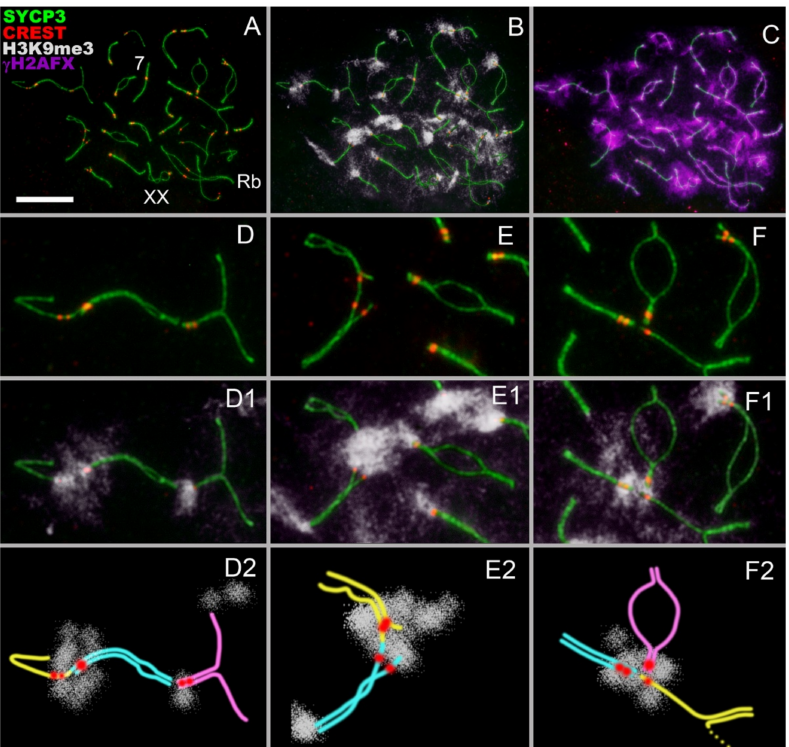
Figure 3. Meiotic contacts of nonhomologous chromosomes in zygotene and H3K9me3 histone distri- butions in E. alaicus spermatocytes. Immunostained nucleus ( A – C ), its enlarged parts ( D – F , D1 – F1 ), and schemes of meiotic contacts ( D2 – F2 ) are presented. Axial and lateral elements of the SCs were visualized using the anti-SYCP3 antibody (green). Kinetochores were detected using the anti-CREST antibody (red). Heterochromatin was detected by means of an anti-H3K9me3 antibody (white). Chromatin inactivation was revealed using an anti- γ H2AFX antibody (violet). The non-Robertsonian chromosome is designated as 7 according to the karyotype [28,29]. The contact regions of nonhomol- ogous bivalents are localized in the H3K9me3 clouds. Scale bar (A–C) = 5 µ